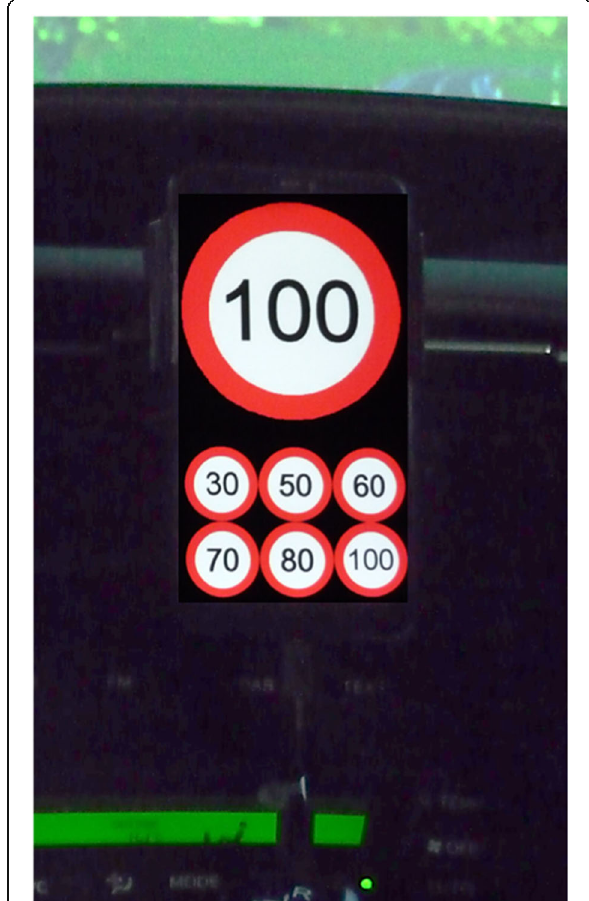
Fig. 1 The display of the speed app used in the study. Above, the current speed limit is indicated by a large rondel, which also flashed as a warning to drivers exceeding the speed limit. Using the smaller rondels below, the driver was able to set the current speed limit in the Active